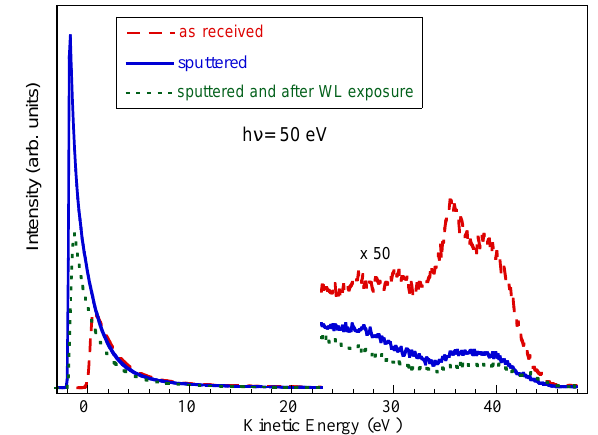
FIG. 10. (Color) The photoemission spectra, taken at 50 eV photon energy, of Pd as received, after WL exposure, after annealing in UHV (pressure during annealing was less than 5 3 10 2 9 mbar) at (cid:2) 300 6 30 (cid:3) ± C for 8 h (Pd-an.), and after WL exposure of the annealed surface.